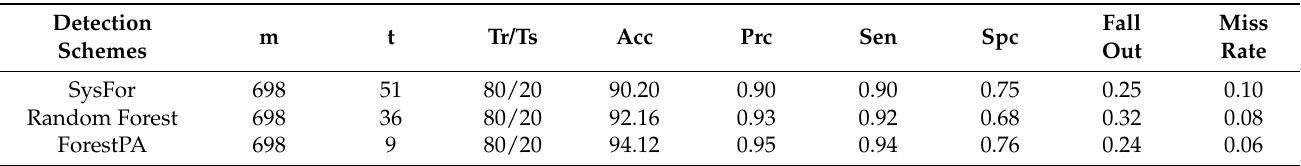
Table 9. Maximum performance received for decision forests with minimum number of decision trees on derived feature segments of Istanbul acoustic dataset.